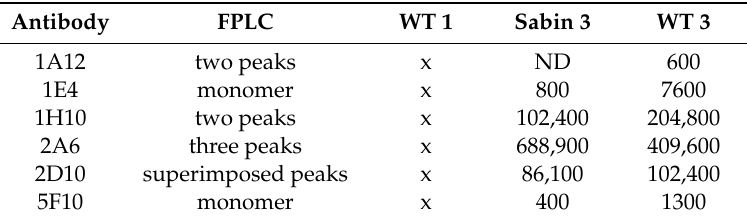
Table 1. Poliovirus neutralizing activities of the hybridoma-expressed IgA mAbs.